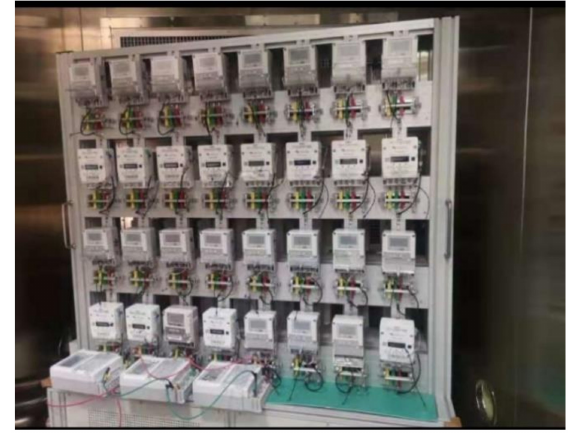
Figure 15. Sample meter for the accelerating life test.